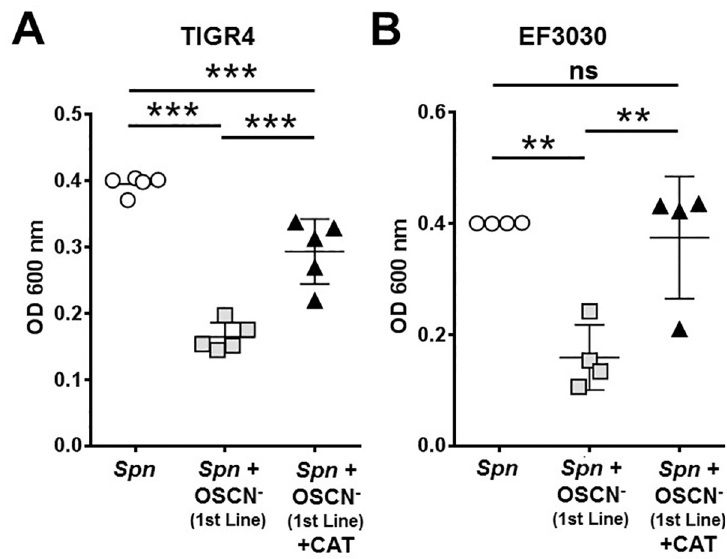
Fig 4. OSCN - generated using commercially available 1st line ™ effectively inhibits Spn growth. The 1st line ™ product efficiently inhibits Spn growth: (A) TIGR4 (n = 5) and (B) EF3030 (n = 4) bacterial strains. Catalase reversed this effect partially (TIGR4) or fully (EF3030). Bacterial growth was measured by the microplate-based growth assay. Each symbol represents a separate, individual experiment, mean+/-S.E.M. One-way ANOVA, Tukey’s multiple comparison test. Each experiment was done in biological triplicates and each biological replicate was tested in technical triplicates. �� , p < 0.01; ��� , p < 0.001; ns, not significant. CAT, catalase.